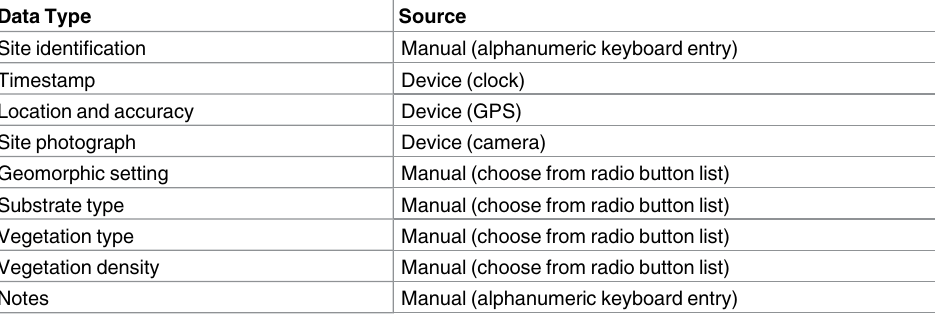
Table 1. Data collected in the iPlover application and source of input within the smartphone